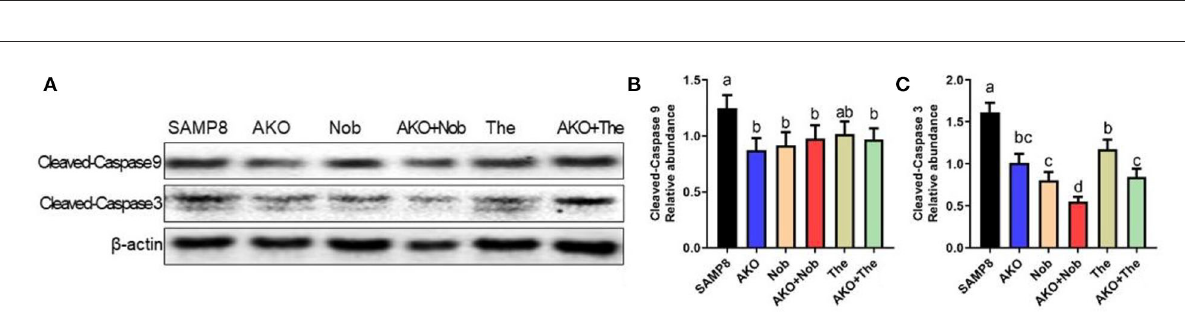
FIGURE4 Effects of apoptosis on the brain. (A) The representative bands were determined by western blotting. (B,C) The relative expressions of Cleaved-Caspase 9 (B) and Cleaved-Caspase 3 (C) . All data were presented as mean ± SEM. Different letters indicate a significant difference at p < 0.05 by